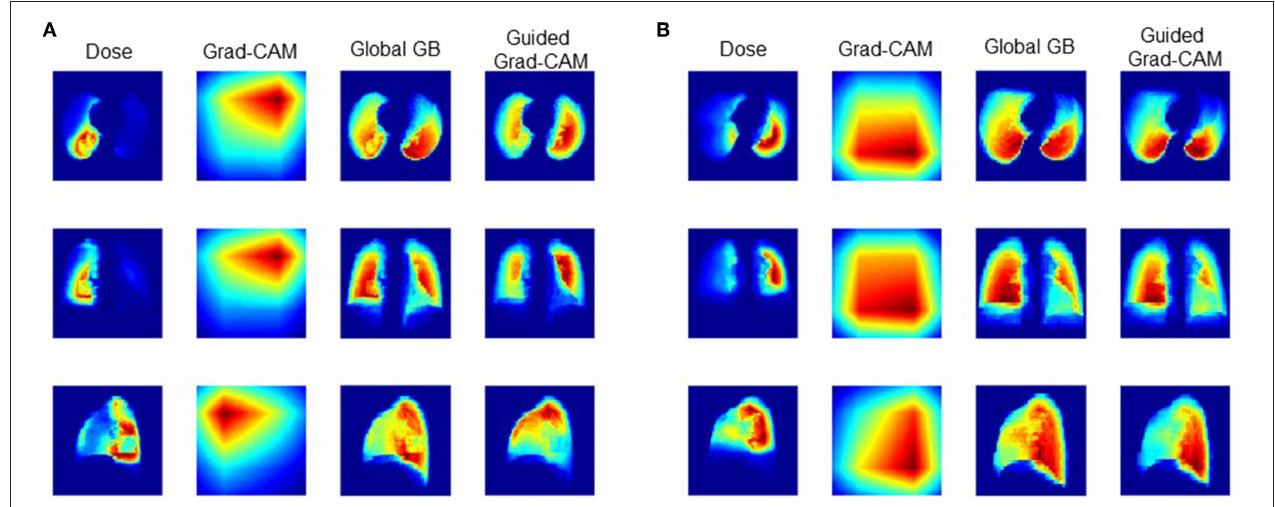
FIGURE 3 | Comparison of RP and None-RP cases. (A) RP grade 2 case, (B) RP grade 0 case.